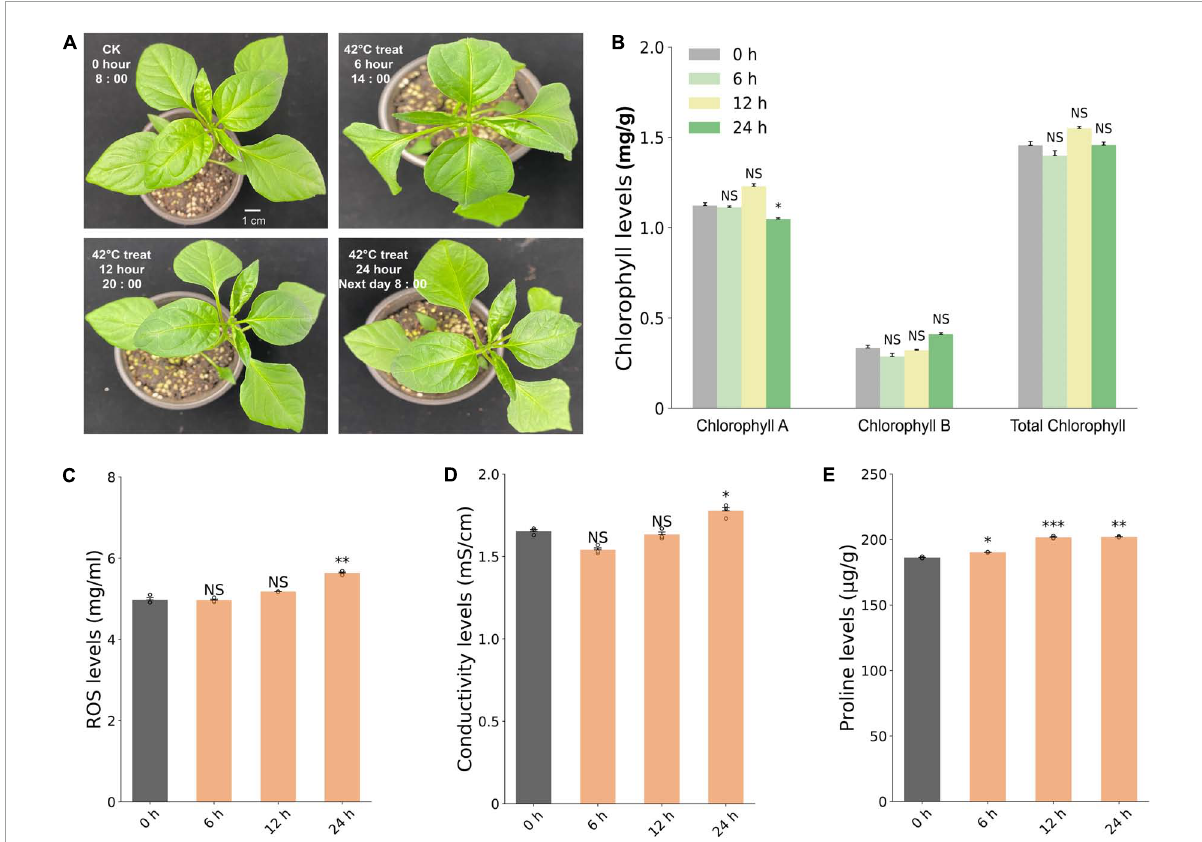
FIGURE2 Phenotypic and physiological responses of pepper line 6421 under 42 ◦ C heat stress. (A) Seedlings of control (0 h) and heat (6, 12, and 24 h at 42 ◦ C) treatments. Changes in the content of chlorophyll including chlorophyll A, chlorophyll B, and total chlorophylls (B) , the content of ROS (C) , conductivity (D) , and the content of proline (E) . Student’s t -test was conducted to compare each heat treatment time point with the 0-h control treatment. Stars indicate significance with one, two, and three stars representing significance at * P < 0.05, ** P < 0.01, and *** P < 0.001, respectively. NS: no significant difference. Error bar represents the standard deviation of each mean ( n =